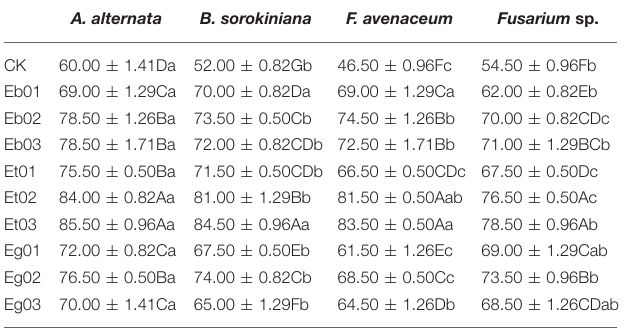
TABLE 2 | Germination rate (%) of Elymus sibiricus under seed-borne fungi stress resulting from effects of the Epichloë endophyte.